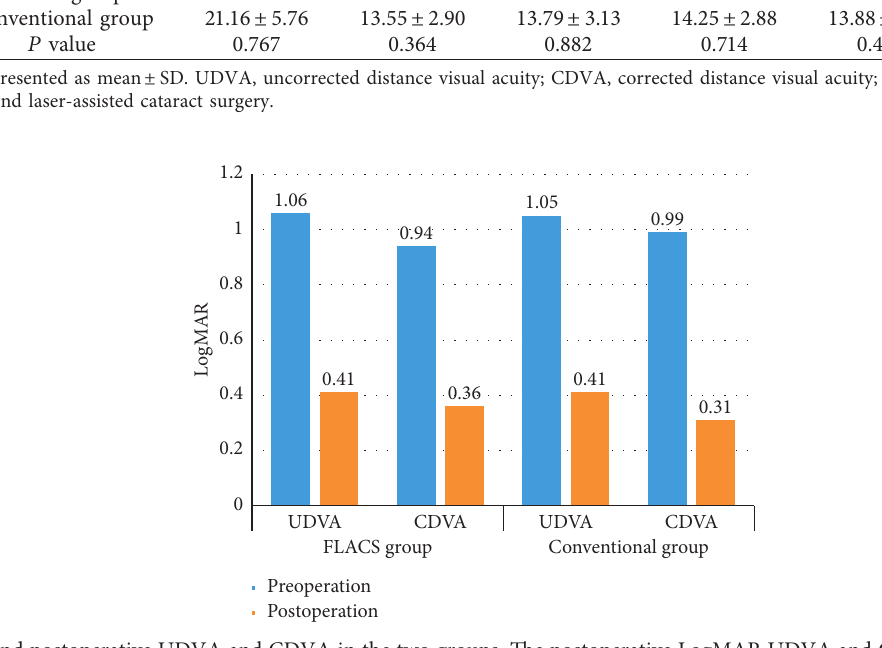
Figure 1: Pre- and postoperative UDVA and CDVA in the two groups. The postoperative LogMAR UDVA and CDVA were better than preoperation in both groups ( P <